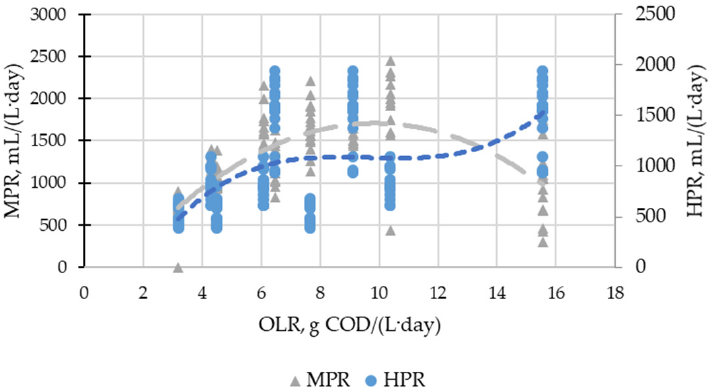
Figure 4. Dependence of methane production rate (MPR) and hydrogen production rate (HPR) on OLR.